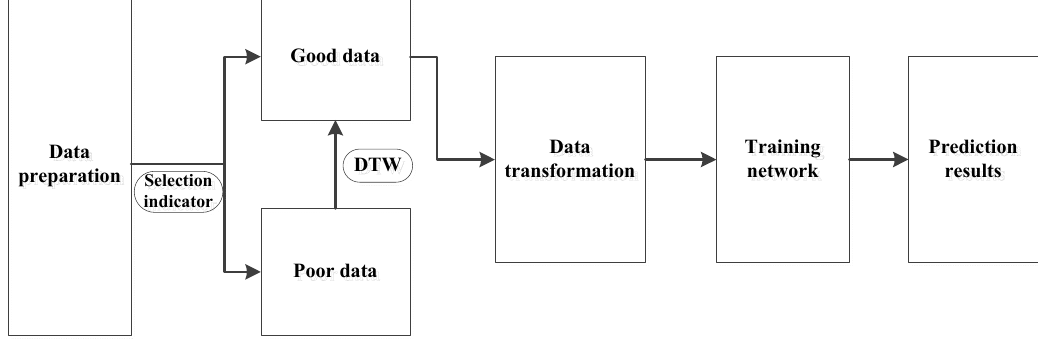
Figure 1. The flowchart of the method proposed in this paper.